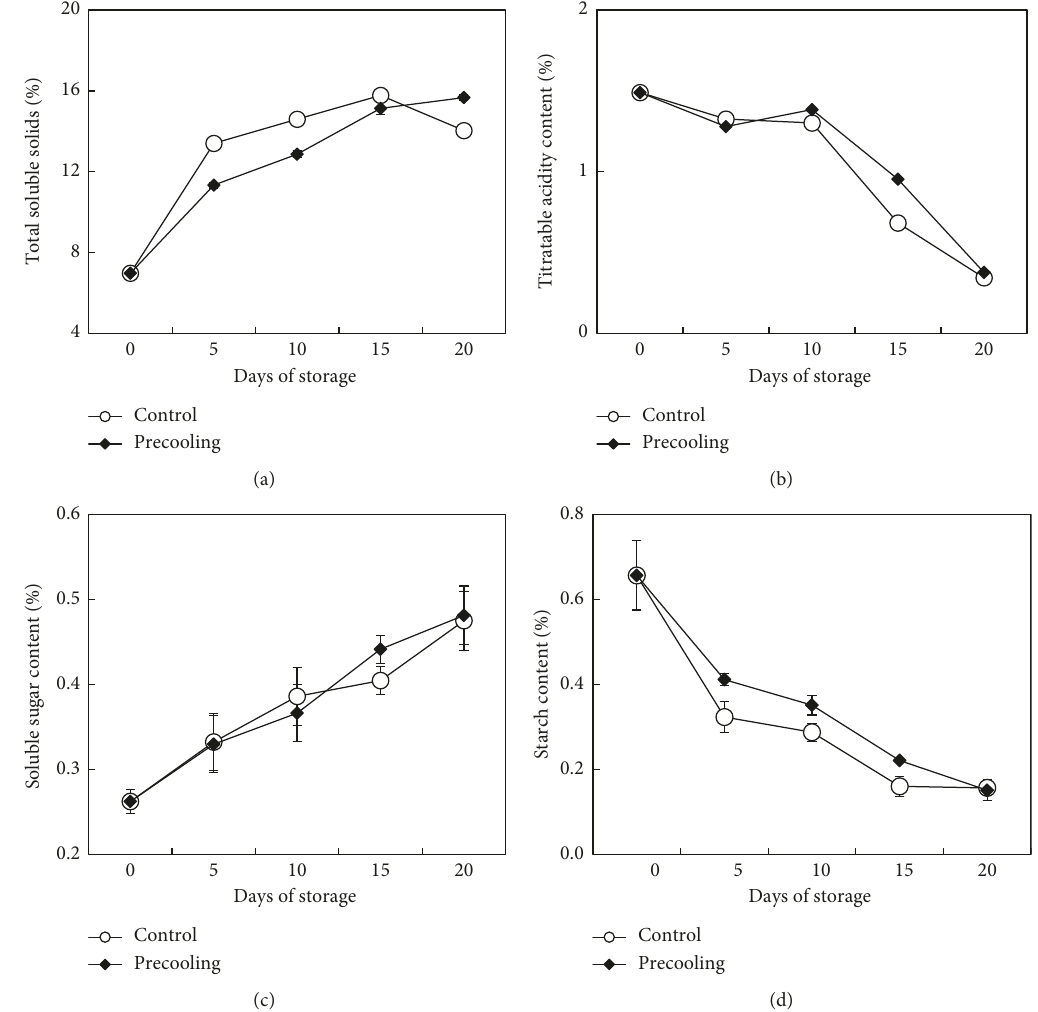
F IGURE 4: Effects of forced air precooling treatment on TSS (a), TA (b), soluble sugar (c), and starch (d)